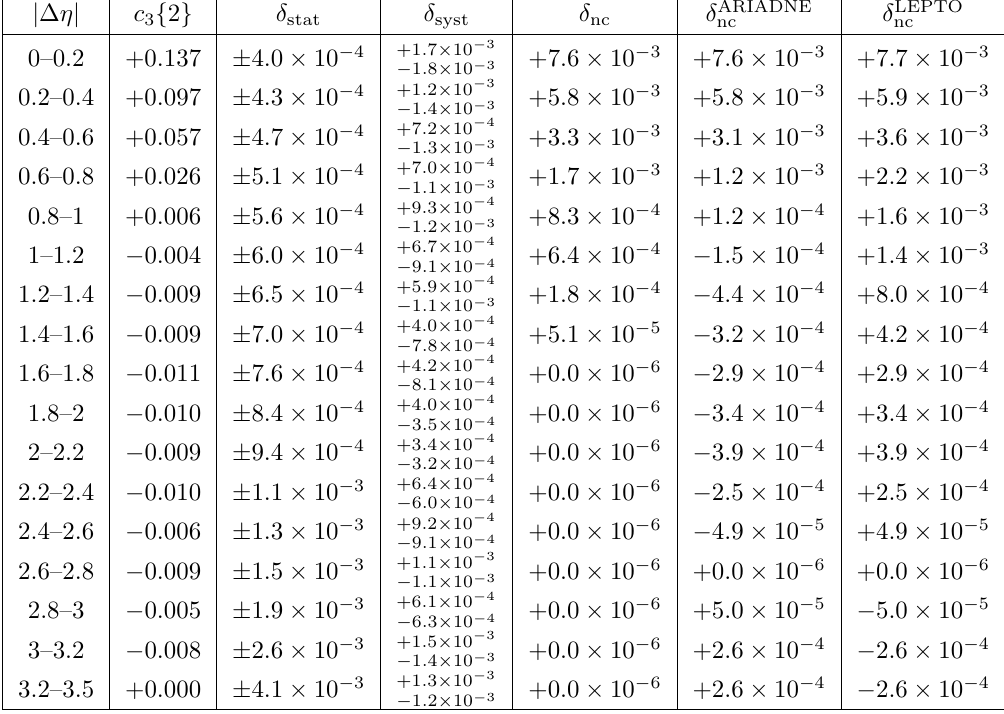
Table 18 . c 3 f 2 g versus j (cid:1) (cid:17) j from (cid:12)gure 8 (c), p T > 0 : 5 GeV; (cid:14) stat , (cid:14) syst and (cid:14) nc denote the statistical, systematic and Monte Carlo non-closure uncertainties,